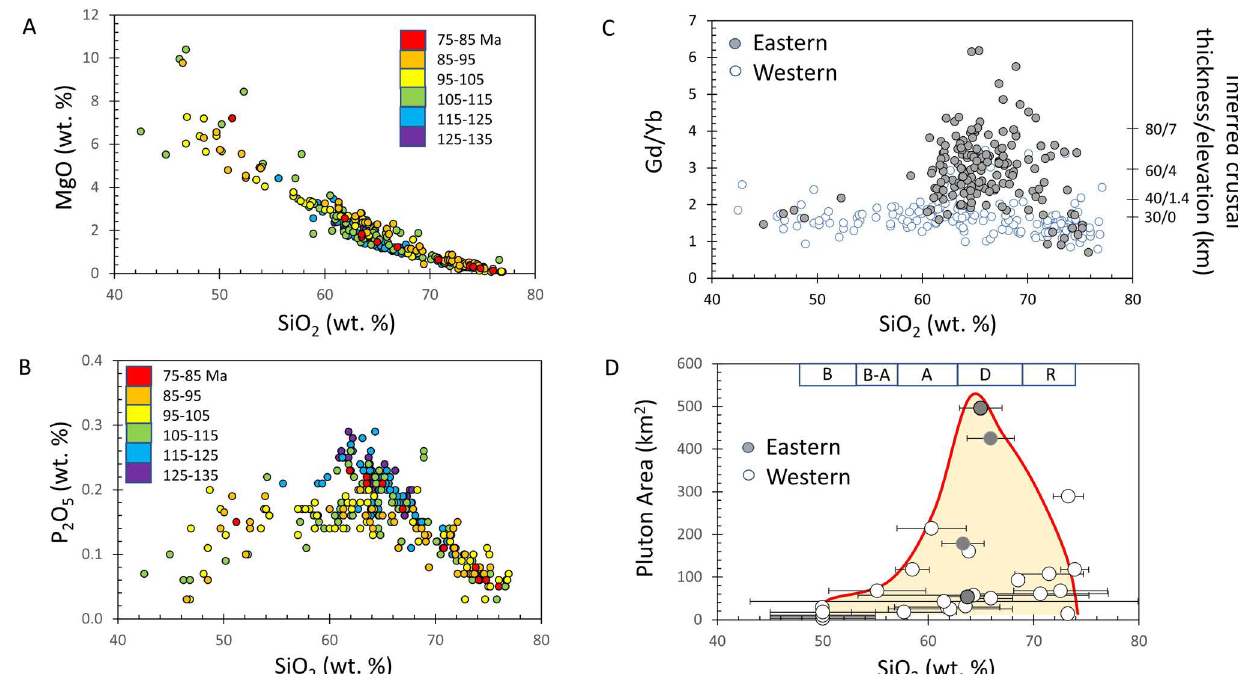
Figure 2: Compositional characteristics of the northern Peninsular Ranges Batholith. [A] MgO versus SiO 2 (wt. %) color-coded according to crystallization age. [B] P O versus SiO (wt. %) color-coded according to crystallization 2 5 2 age. [C] Gd/Yb (ppm/ppm) versus SiO (wt. %). Gray symbols represent Eastern and Eastern Transition Zone sam- 2 ples and open symbols represent Western and Western Transition Zone samples from Figure 1. Right hand axis corresponds to approximate crustal thickness and elevation inferred from global empirical relationships between Gd/Yb and elevation of arc volcanoes. The first number represents crustal thickness and the second represents elevation (km). Data are based on published literature [Lee et al. 2007; Morton et al. 2014b]. [D] Pluton area (km 2 ) versus average SiO content of the pluton (see Table 1). Horizontal error bars represent 1 standard deviation for 2 SiO . It is impossible to estimate internal errors on estimates of pluton area; a more relevant issue is the accuracy 2 and representativeness of pluton area as pluton volume (see text). Gray symbols represent Eastern and Eastern Transition Zone plutons and white symbols represent Western and Western Transition Zone plutons. Red line rep- resents a qualitative bounding line defining the maximum pluton sizes. Symbols in top horizontal bar correspond to the fields for rhyolite (R), dacite (D), andesite (A), basaltic-andesite (B-A), and basalt